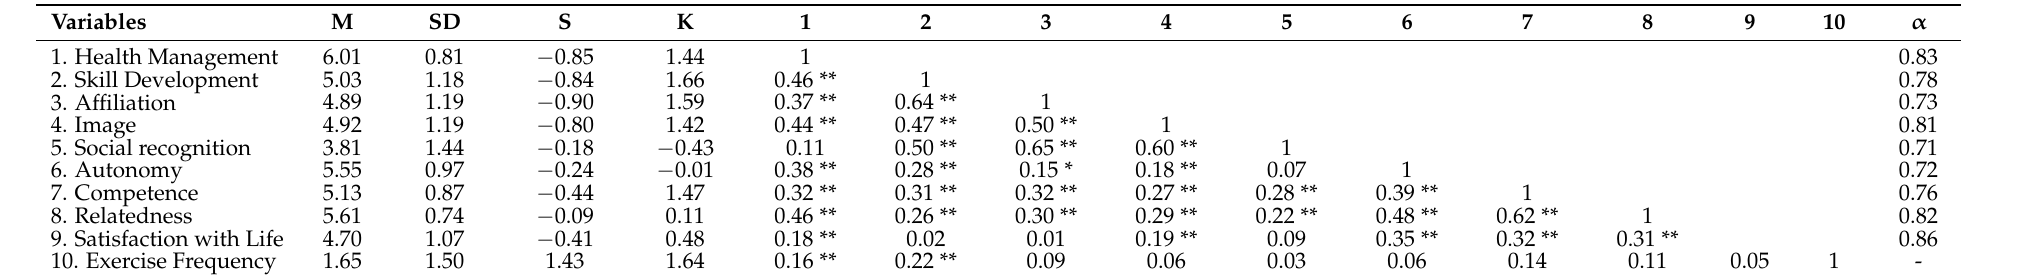
Table 1. Descriptive statistics, composite reliability coefficients, and latent